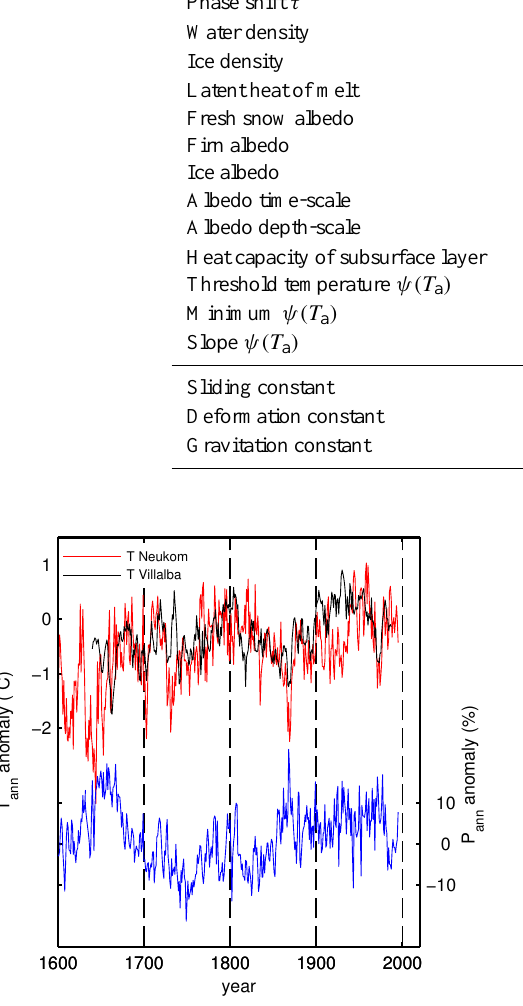
Fig. 4. Annual temperature anomaly from the Villalba et al. (2003) (black) and Neukom et al. (2011) (red) and annual relative precipita- tion anomaly from Neukom et al. (2010) (blue) w.r.t. the 1980–2009 mean. The annual anomalies from Neukom et al. (2010, 2011) are constructed from summer and winter anomalies as described in the